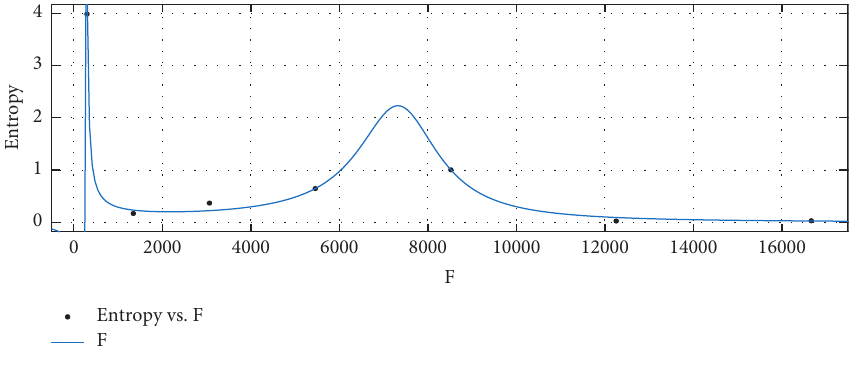
Figure 21: F versus Ent.